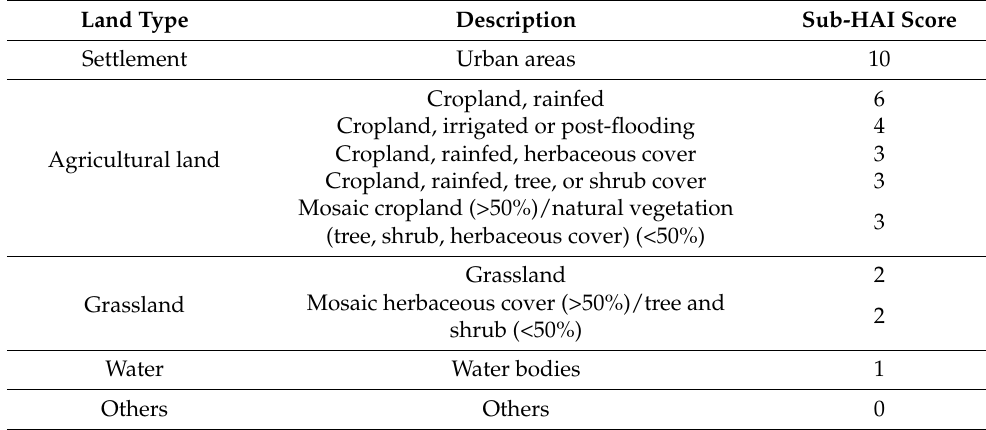
Table 1. Land cover datasets and sub-HAI scores.